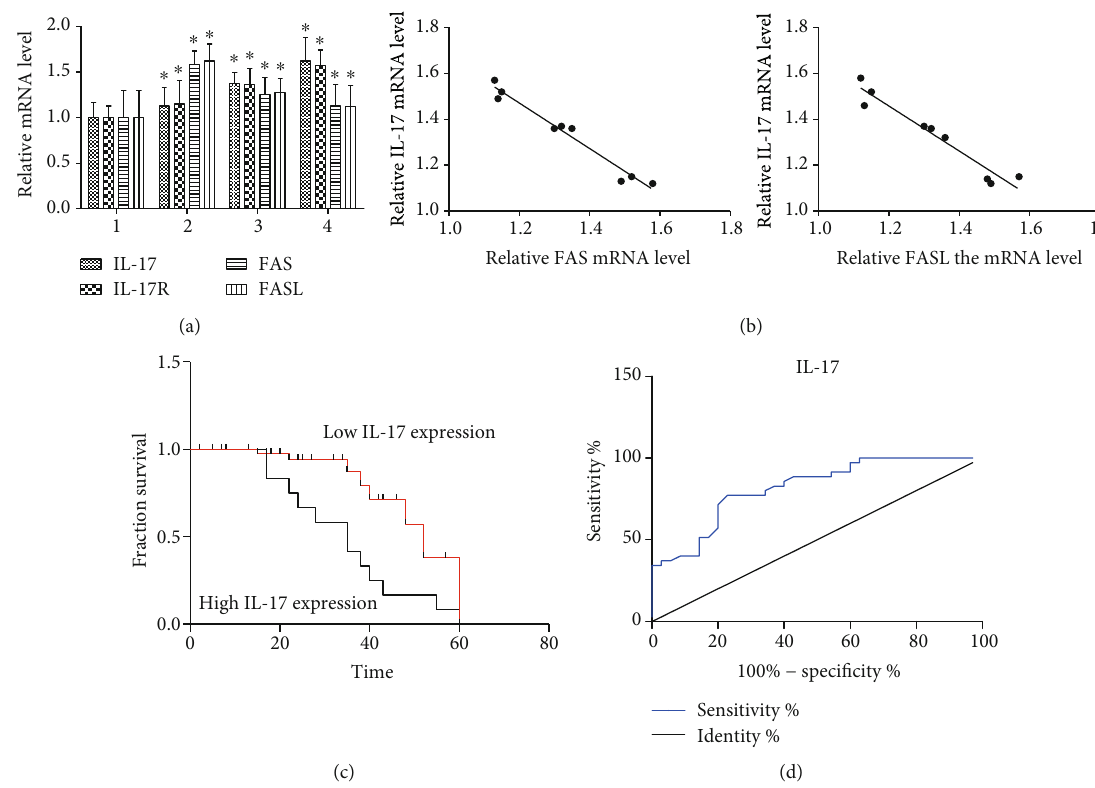
Figure 2: Relative expression of IL-17, IL-17R, FAS, and FASL at the mRNA level in paracancerous tissues of the control group and di ff erent pathological grades of LC tissues. One representative experiment of the three independent experiments is demonstrated. ∗ P < 0 : 01 compared with the control group. 1=paracancerous tissues of the control group, 2=well-di ff erentiated group, 3=moderately di ff erentiated group, and 4=poorly di ff erentiated group. (a) IL-17, IL-17R, FAS, and FASL expression was determined using the reverse transcription-quantitative polymerase chain reaction. (b) The scatter plot of IL-17, FAS, and FASL expression revealed a strong negative correlation, indicating that IL-17 expression was correlated with the apoptosis in LC cells ( r = − 0 : 82 for FAS and r = − 0 : 847 for FASL, and all P < 0 : 01 ). (c) Disease- free survival by IL-17 expression in LC patients ( n = 60 ). (d) The ROC curves and AUC values of IL-17 expression ( AUC = 0 : 8184 , 95% CI: 0.721-0.915, and P < 0 : 0001 ). Expression of the IL-17 and IL-17R proteins in LC tissues from patients at di ff erent pathologic